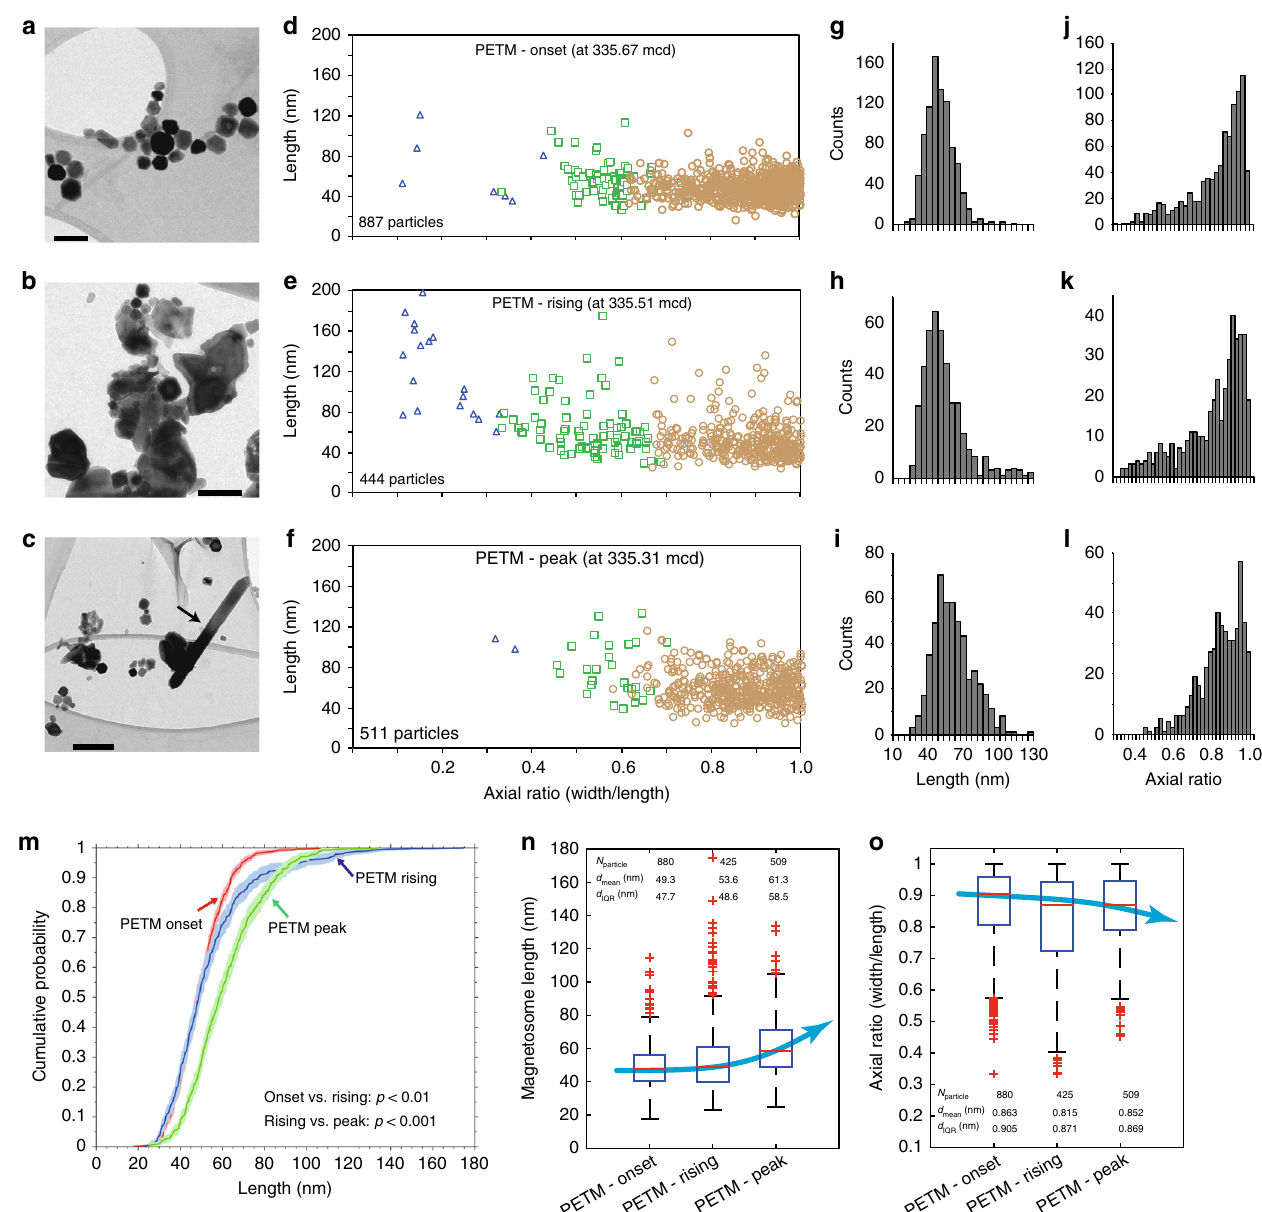
Fig. 4 TEM observations and statistical analyses of magnetofossil morphologies for three typical PETM samples from ODP Hole 1263C. a – c Bright- fi eld TEM images. Scale bars in a and b , c are 100 and 200 nm, respectively. The arrow in c indicates a needle-shaped giant magnetofossil crystal. d – f Length – axial ratio (width/length) diagrams for magnetofossil crystals measured from the TEM images. Magnetofossil morphologies are categorized into three main groups: isotropic or nearly isotropic octahedral and cubo-octahedral crystals (orange circles), elongated crystals and prisms (green squares), and bullet-shaped (blue triangles) crystals. The number of counted magnetofossil crystals is shown. Histograms of g – i length and j – l axial ratio for magnetofossils excluding bullet-shaped crystals. m Cumulative probability of length of magnetofossils excluding bullet-shaped crystals for the three samples with Kolmogorov – Smirnov test results. Box-whisker plots of n length and o axial ratio of magnetofossils excluding bullet-shaped crystals. The samples are the same as in Fig. 2. ( a , d , g , j ), ( b , e , h , k ) and ( c , f , i , l ) are for PETM onset, rising and peak samples,